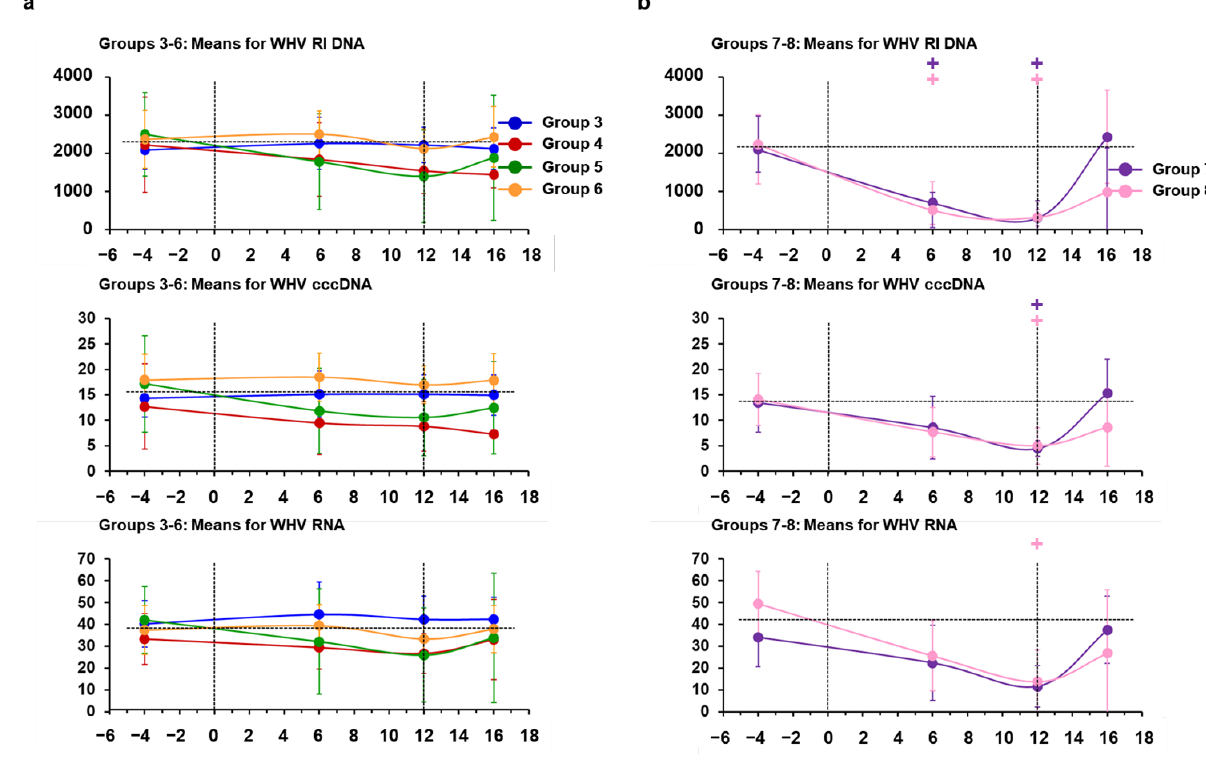
Figure 9. hzVSF minimally reduces WHV replication in the liver, but suppression is pronounced in combination with TAF. Comparison of means of ( a ) Groups 3–6 treated with placebo or hzVSF at a low, intermediate, and high dose and ( b ) Groups 7–8 treated with TAF, alone or in combination with hzVSF at an intermediate dose, relative to the pretreatment baseline (week −4) for intrahepatic levels of WHV DNA RI, cccDNA, and RNA. Vertical lines indicate the standard error of the mean. Horizontal dotted lines present the mean WHV nucleic acid levels of Groups 3–6 or Groups 7–8 at baseline. For the purpose of graphical presentation, hepatic WHV nucleic acids and antigens determined in terminal liver tissues after the EOS during weeks 17–19 are shown at week 16 in this and the following figure. WHV DNA RI and cccDNA in Groups 7 and 8 were significantly reduced compared to the baseline at weeks 6 and 12 or at week 12, respectively (+: p < 0.05). Compared to the baseline, WHV RNA in Group 8 was significantly reduced at week 12 (+: p < 0.05).